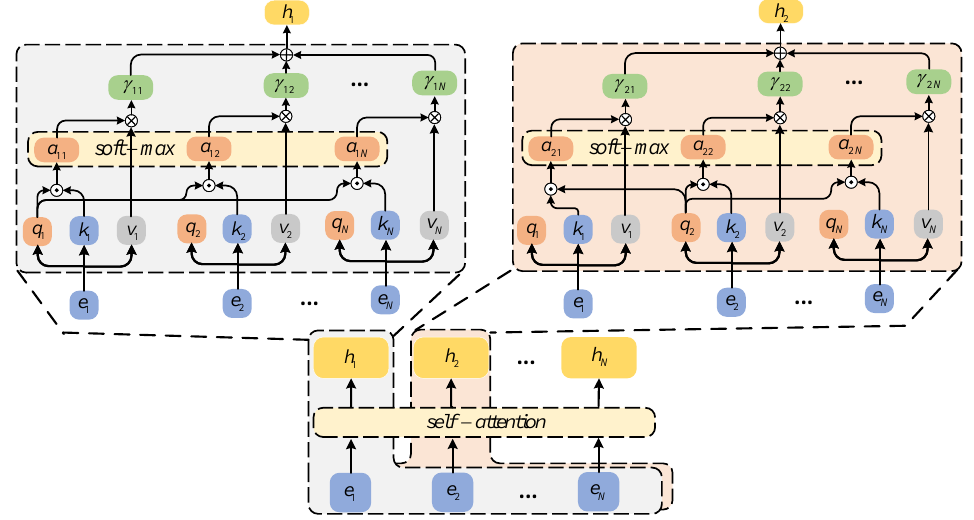
Figure 6. The structure of self-attention